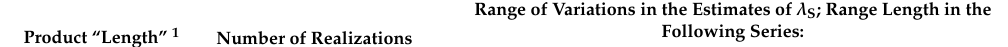
Table 4. Estimating the stochastic growth rate, λ S , of the local A. albana population by the direct Monte Carlo